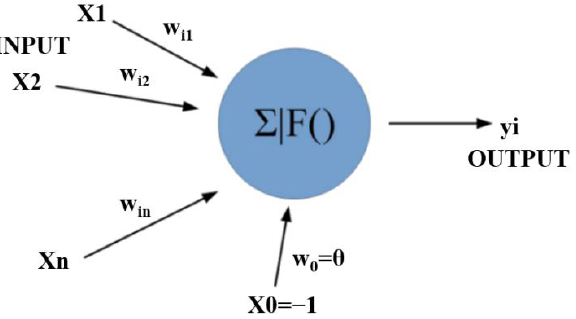
Figure 5. Schematic diagram of the back propagation neuron calculation.